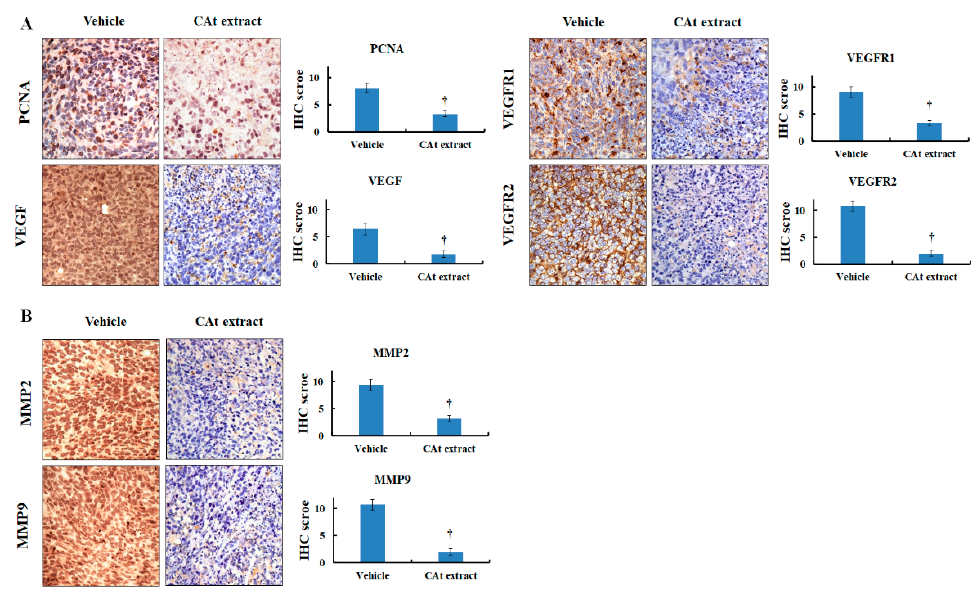
Figure 7. CAt-extract-induced inhibitory e ff ect in the HCC xenograft tumor model by IHC staining. Indicated protein expression in HCC tumor tissues was stained by IHC. ( A ) The level of PCNA, VEGF, VEGFR1, and VEGFR2 protein. ( B ) The level of MMP2 and MMP9 protein. † : A significant di ff erence between control and treatment, p < 0.05. Table 2. GC-MS analysis of CAt extract.